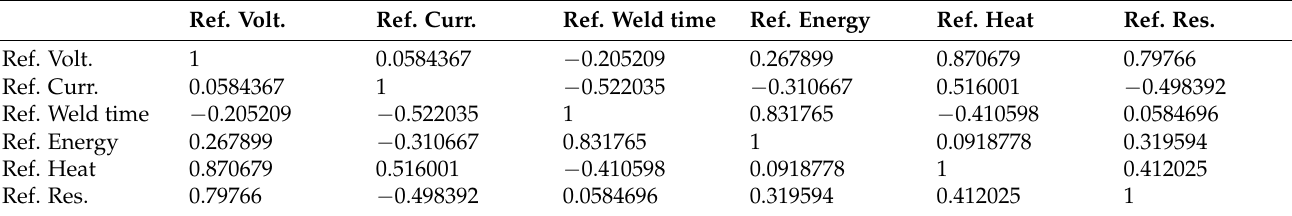
Table 8. Correlation matrix for reference